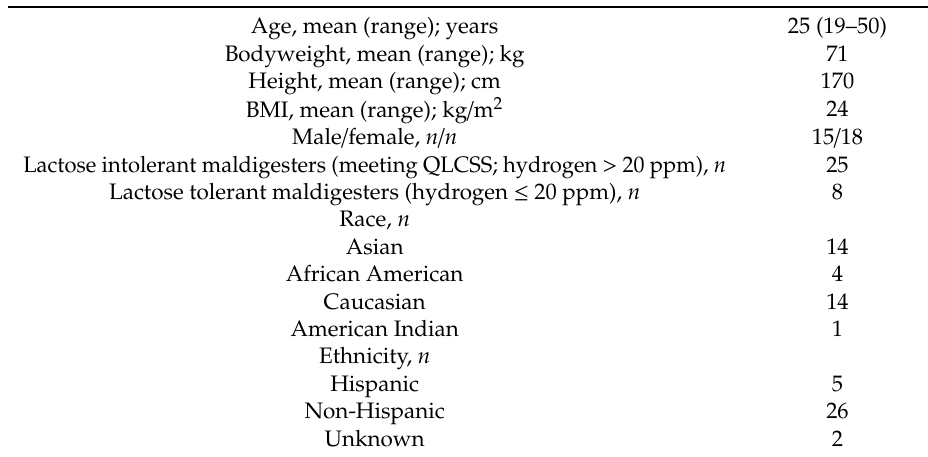
Table 1. Baseline and demographic characteristics.